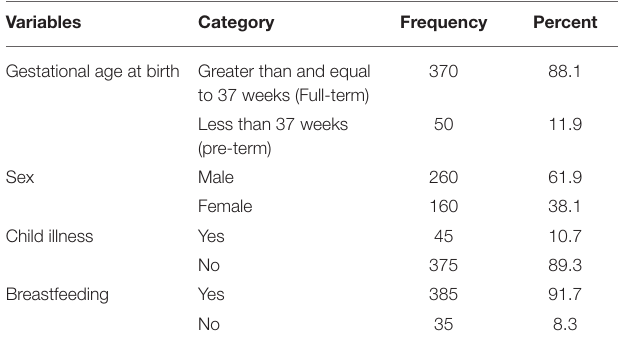
TABLE 4 | Neonatal-related characteristics among post-partum mothers in Debre Tabor town North West Ethiopia 2021.